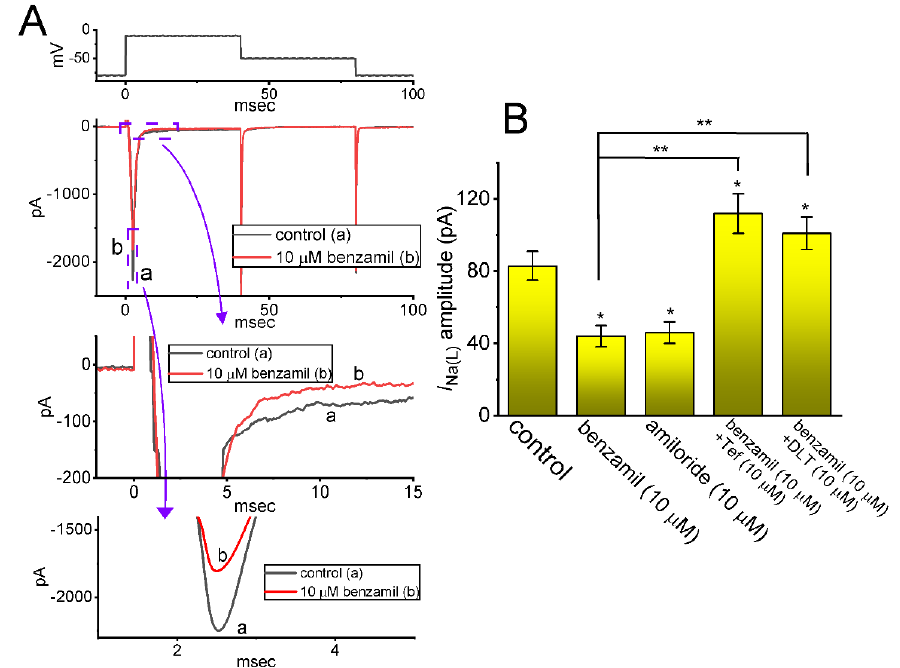
Figure 2. Effect of benzamil, amiloride, benzamil plus tefluthrin (Tef), and benzamil plus deltamethrin (DLT) on I Na measured from GH 3 cells. ( A ) Exemplar current traces elicited by rectangular depolarizing pulse from − 80 to − 10 mV for a duration of 40 ms. a: control (black color); b: in the presence of 10 μM benzamil (b, red color). The uppermost part is the voltage clamp protocol delivered, and the lower part of ( A ) shows the display of the expanded records in each purple dashed box. ( B ) Summary graph demonstrating effects of benzamil, amiloride, benzamil plus tefluthrin (Tef), and benzamil plus deltamethrin (DLT) on the amplitude of I Na(L) (mean ± SEM; n = 7 for each yellow bar). The I Na(L) amplitude was measured at the end of a short depolarizing pulse from − 80 to − 10 mV for a duration of 40 ms. * Significantly different from control ( p < 0.05) and ** significantly different from benzamil (10 μM) alone group( p < 0.05).